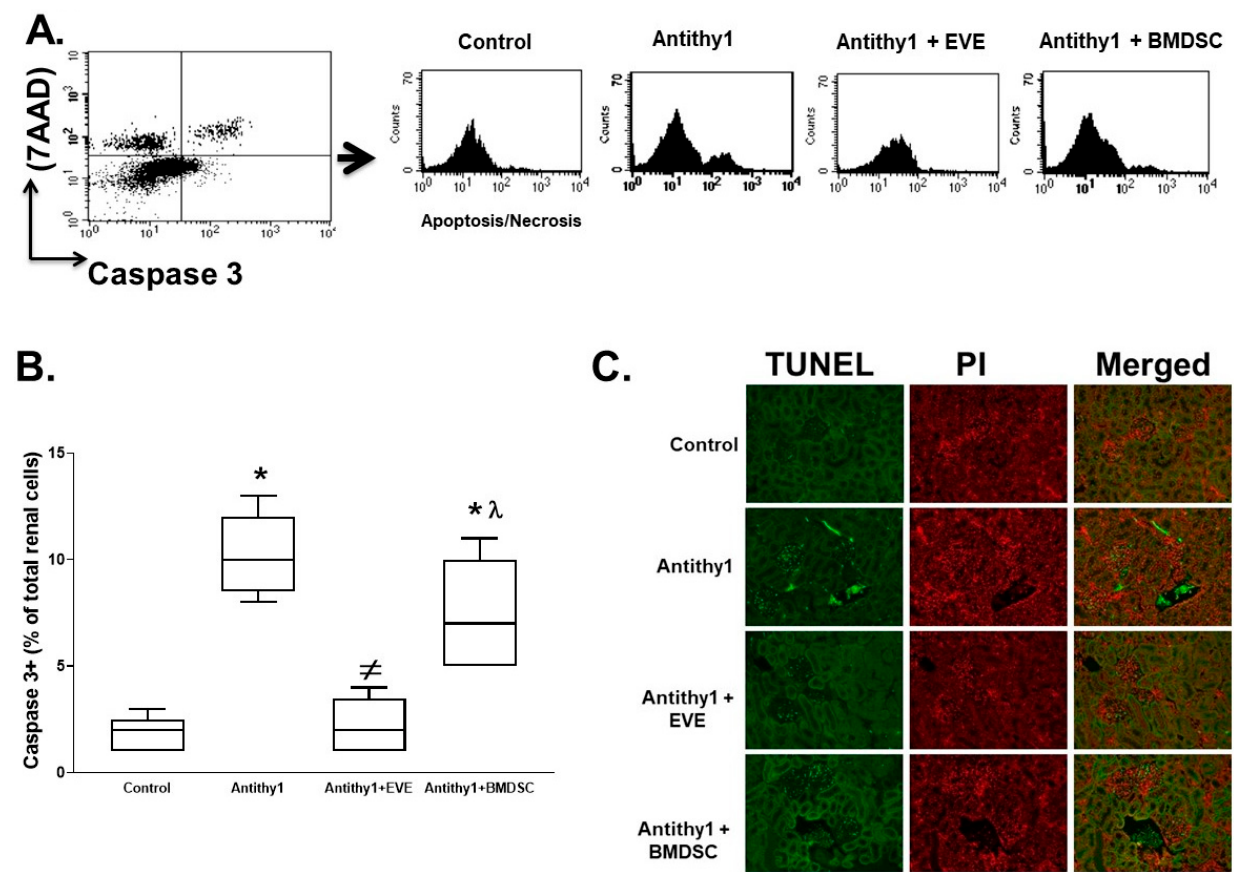
Figure 7. Representative flow cytometry plots ( A ) and % of total renal cells expressing caspase 3+ ( B ) as indicative of apoptosis in control and anti-Thy1-injected rats with or without everolimus or BMDSC treatment. Everolimus was supe- rior to BMDSCs in reducing renal caspase 3 expression in anti-Thy1-injected rats (n = 6, * vs. control, ≠ vs. anti-Thy1-injected rats and λ vs. everolimus-treated rats). The result was further verified using TUNEL assay for renal apoptotic cells in the kidney sections from the same rat group ( C ) where number of renal apoptotic cells increased after anti-Thy1 injection and was only reduced with everolimus